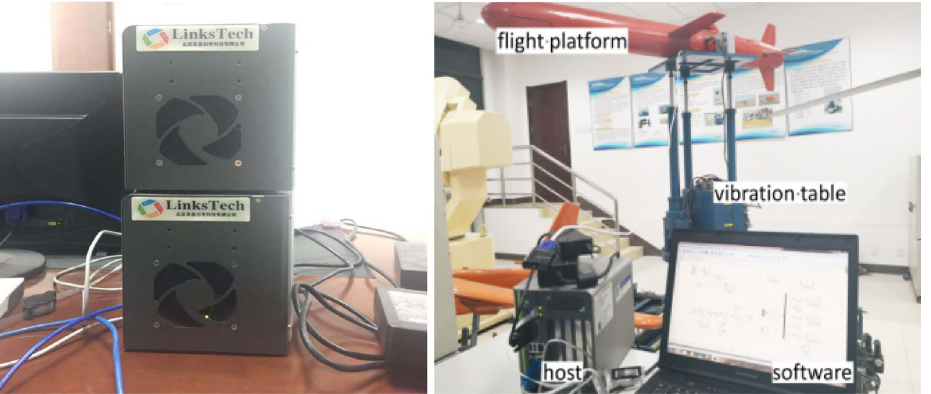
Figure 5. Semi-physical simulation platform.